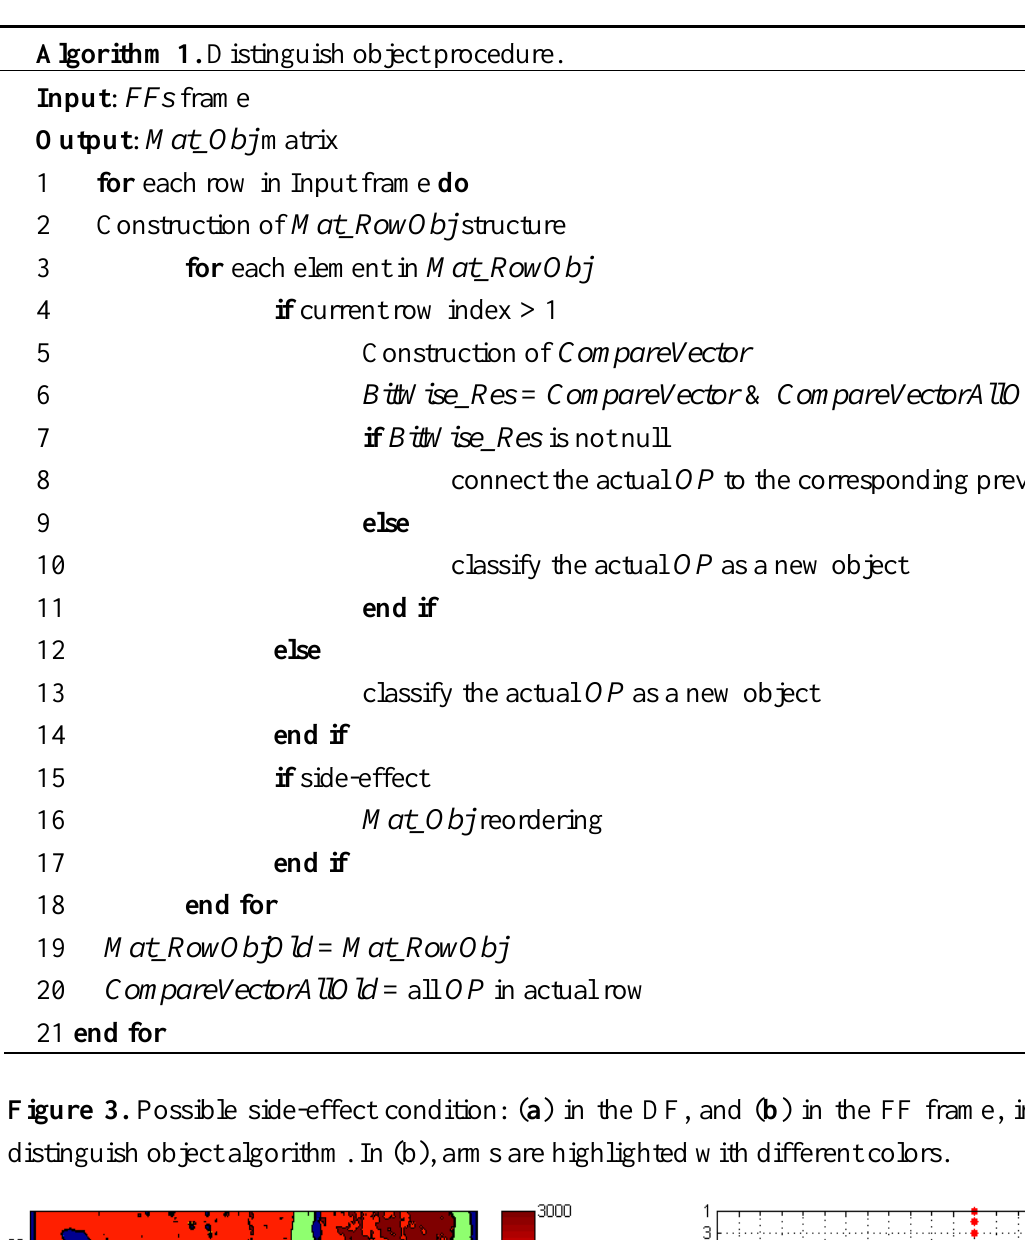
Algorithm 1. Distinguish object procedure.